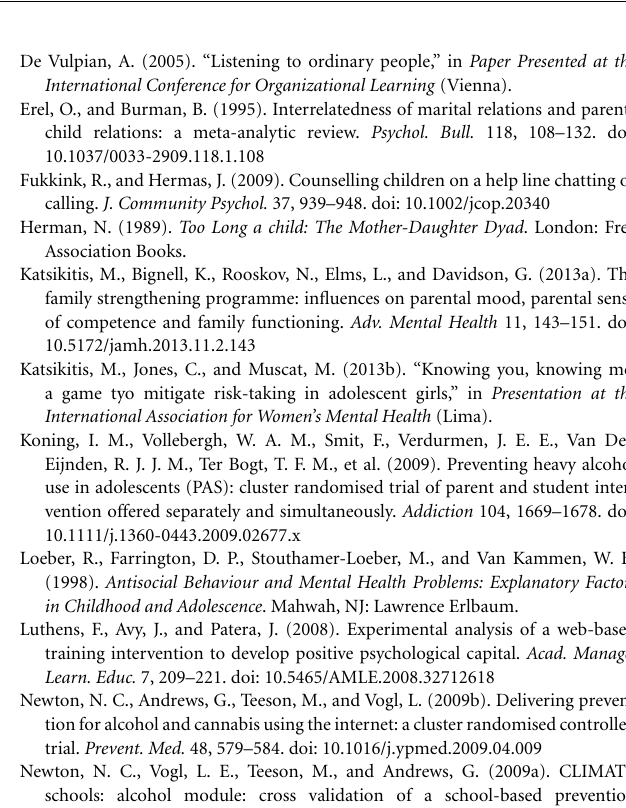
FIGURE 5 | Administrator content management system with snippets (text), media (images and videos), diary questions and SMS